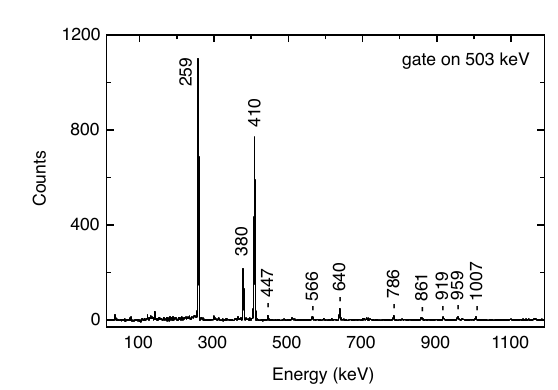
Figure 5. Gamma-ray spectrum from the high-spin β -decay of 146 La showing the main transitions in prompt coincidence with the 503-keV γ ray, depopulating the I π = 6 + level of the ground- state band in 146 Ce daughter